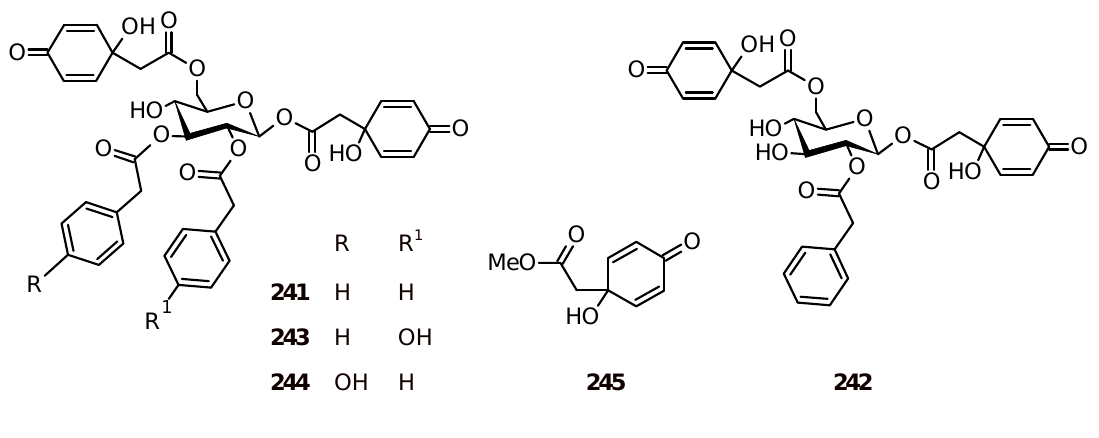
Figure 28. Structures of phenylethanoids 241 - 245